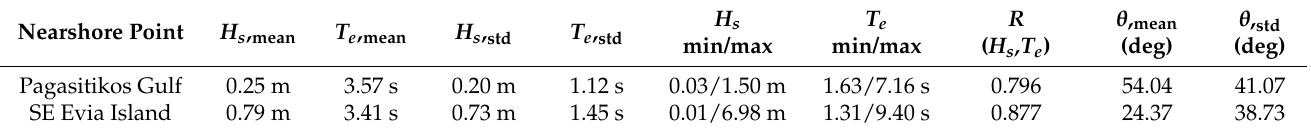
Table 1. Nearshore wave parameters associated with the wave climatology in the considered regions. Nearshore